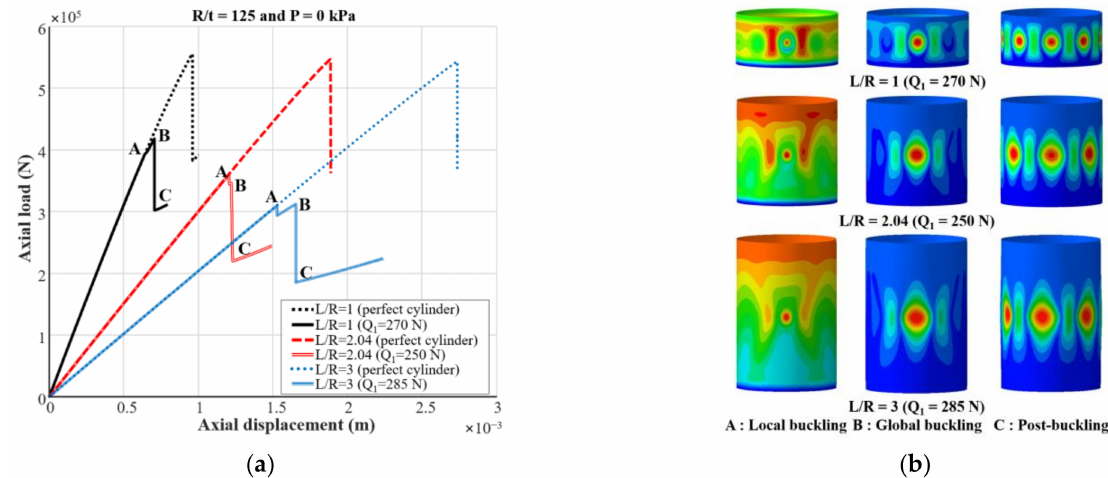
Figure 6. Post-buckling analyses results under axial compression for the cylinders R / t = 125. ( a ) Load-displacement curves, ( b ) Buckling shapes.